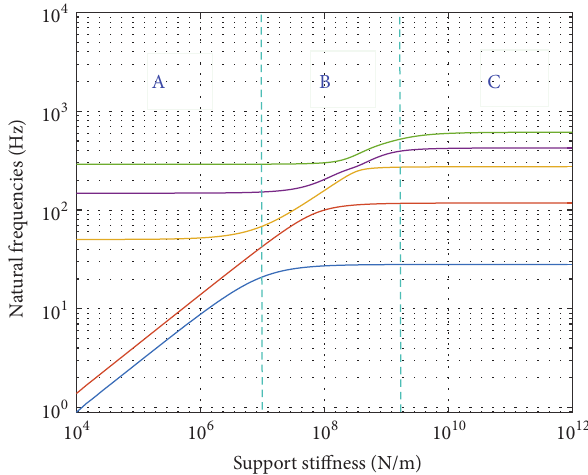
Figure 5: Nature frequencies in dependence of support